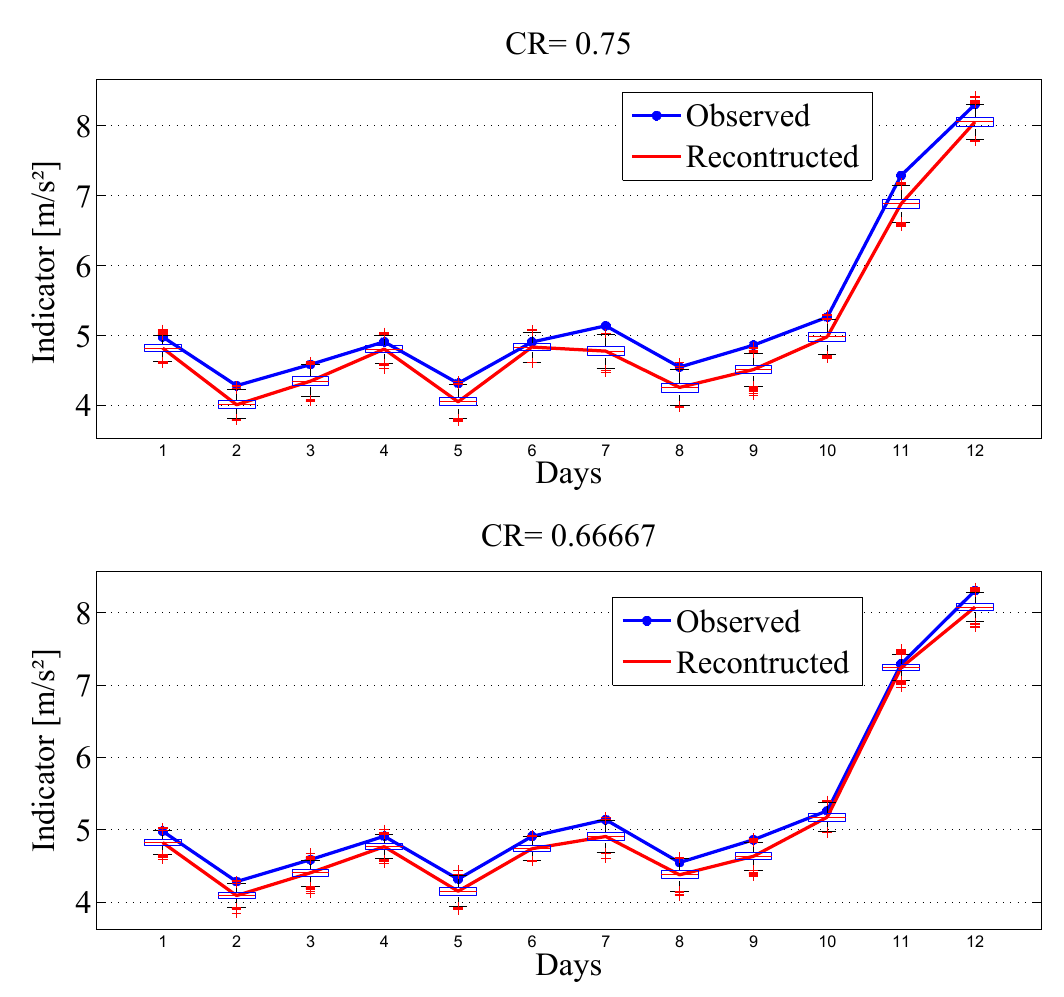
Figure 8. Indicators computed on the raw signals (blue) and on obtained samples (boxplots). The red line shows the